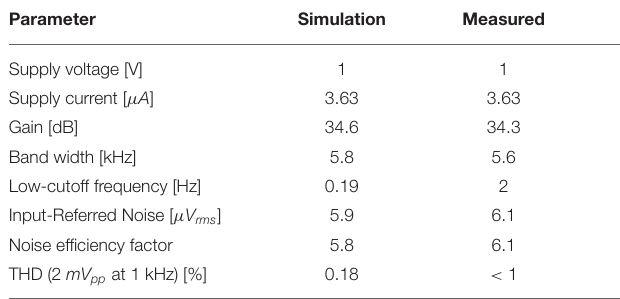
TABLE 3 | Experimental and simulation characteristics of neural